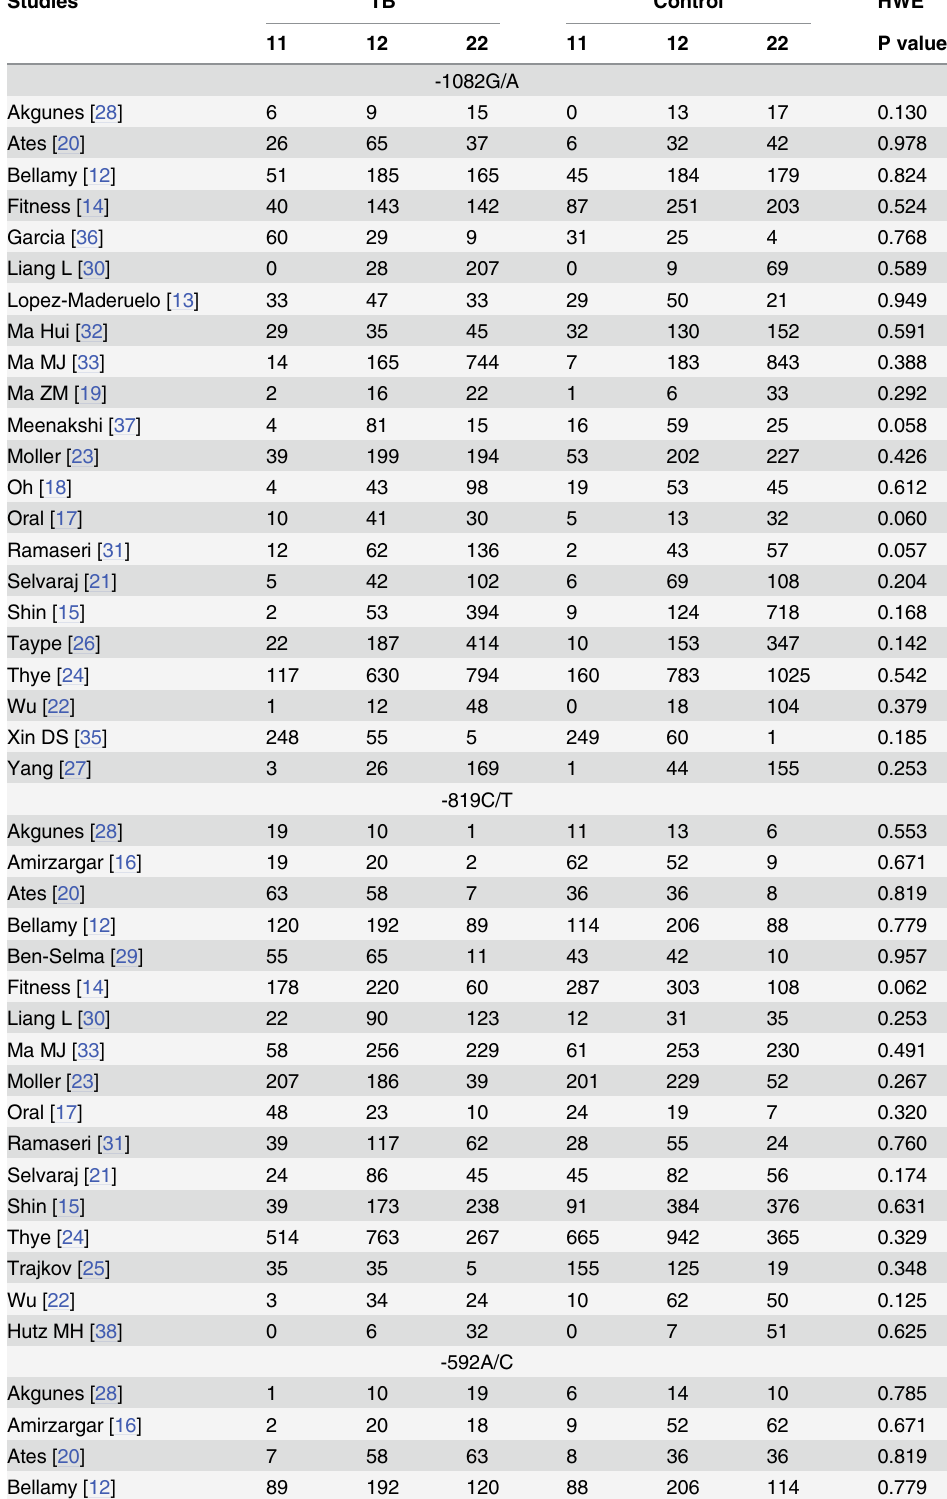
Table 2. Distribution of IL-10 genotypes in patients and